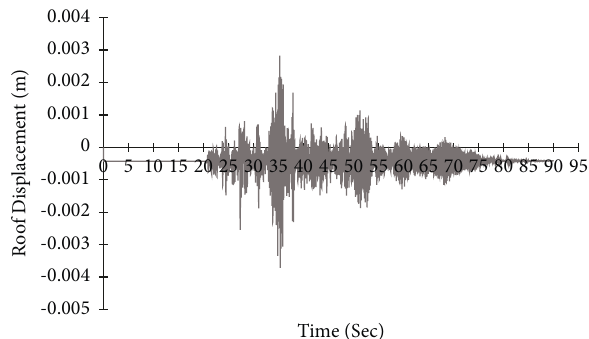
Figure 30: Displacement histories of the timber-steel-BRB